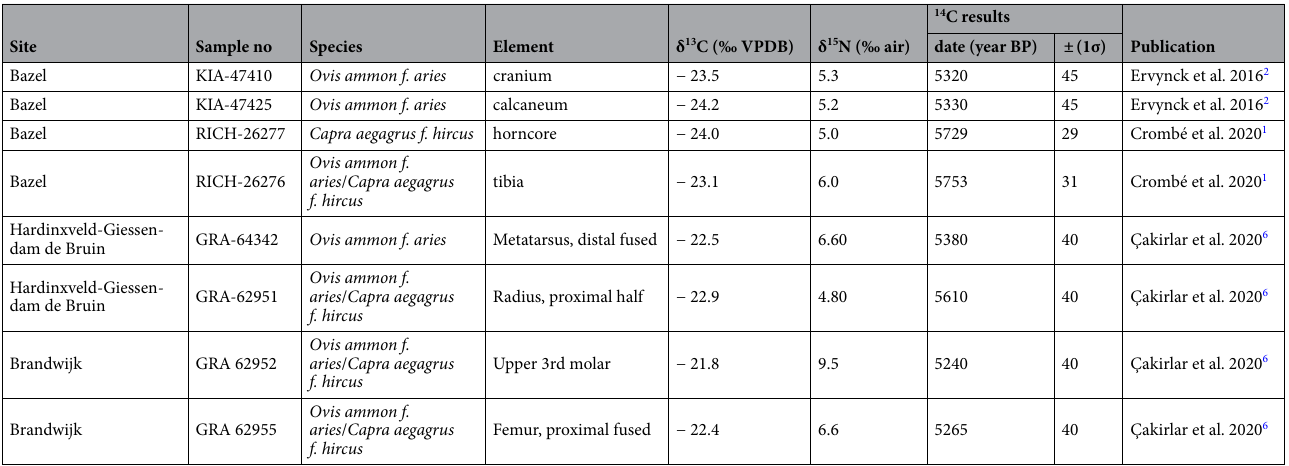
Table 1. Radiocarbon dates of sheep/goat bones from Bazel “Sluis”, Hardinxveld-Giessendam de Bruin, and Brandwijk, shown in Fig.